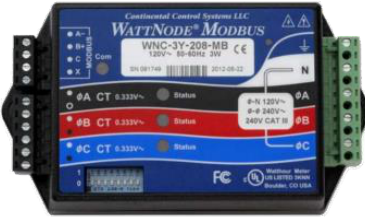
Figure 5. WattNode WNC-3Y-400-MB used as a smart meter.